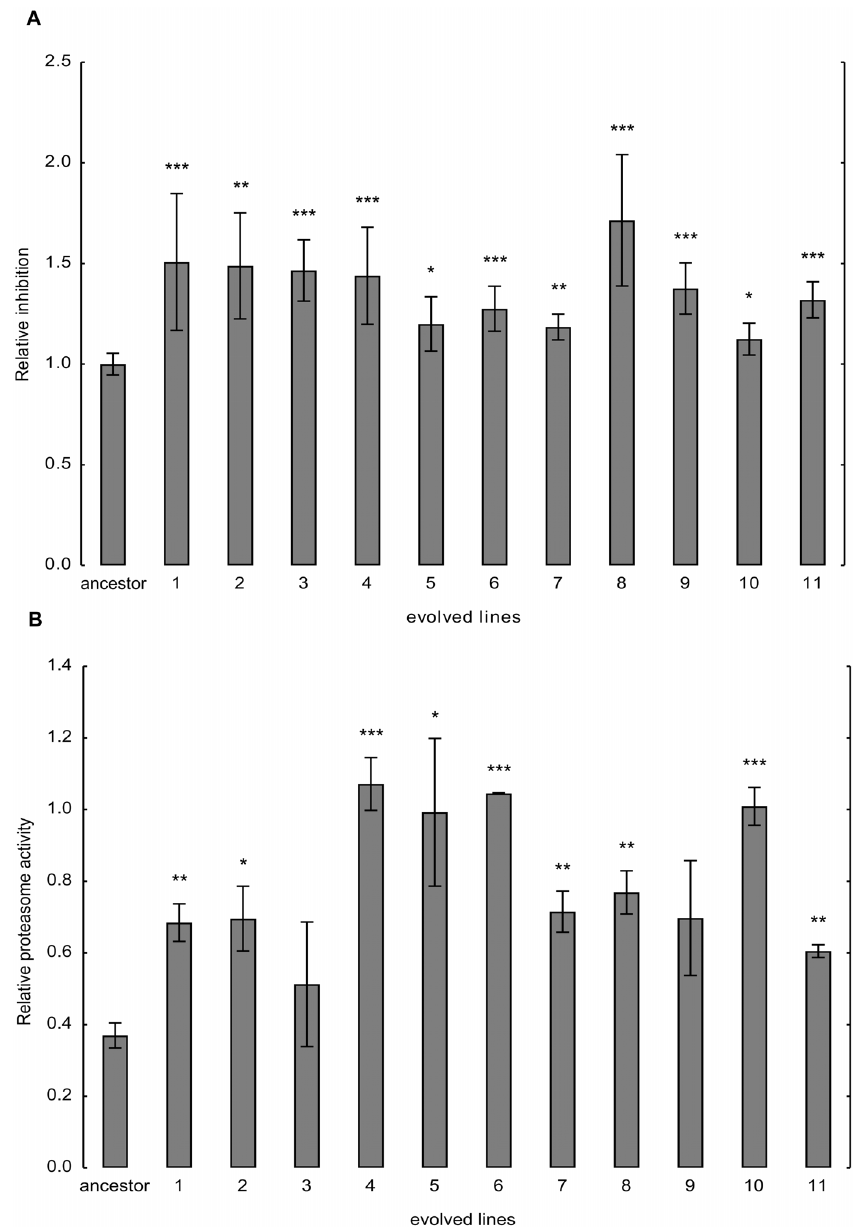
Fig 6. Changes in the ubiquitin-proteasome system during evolution. (A) Inhibition of the ancestor and the evolved lines by cycloheximide. To test the sensitivity of the populations to protein synthesis inhibitor, the growth medium was supplemented with sublethal dosage of cycloheximide (0.06 μ g/ml). Inhibition rates were calculated by comparing growth rates in drug-containing and drug-free media, and were normalized to that of the wild-type control. The bars indicate mean ± 95% confidence interval. Mann-Whitney U test was used to assess difference in fitness between ancestor and evolved lines. * / ** / *** indicates p -value < 0.05/0.01/ 0.001, respectively. To ensure that changes in inhibition rates do not simply reflect the direct effects of mistranslation, tRNA CAGSer was swapped for the corresponding empty vector in the ancestor and the evolved lines. (B) Changes in proteasome activity during evolution. Proteasome activities were normalized to the activity measured in wild-type control carrying no tRNA CAG Ser . The bars indicate mean ± standard error. Two- sample t test was used to assess the difference in proteasome activity between the ancestor and the evolved lines. * / ** / *** indicates p -value < 0.05/0.01/0.001,